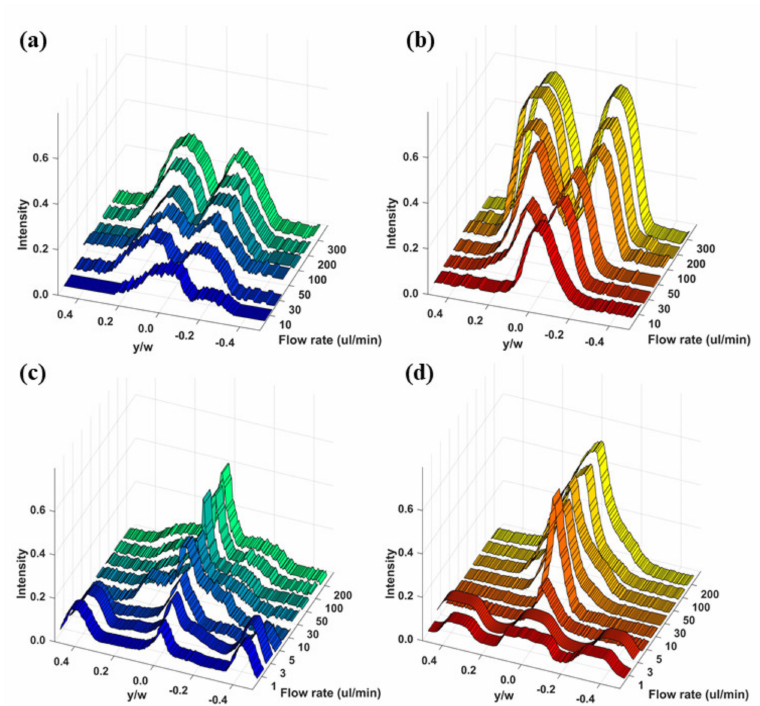
Figure 5. Fluorescence intensities (top view) according to various flow rates: ( a ) 5 µ m and ( b ) 13 µ m particles in the Newtonian fluid, ( c ) 5 µ m and ( d ) 13 µ m particles in the viscoelastic